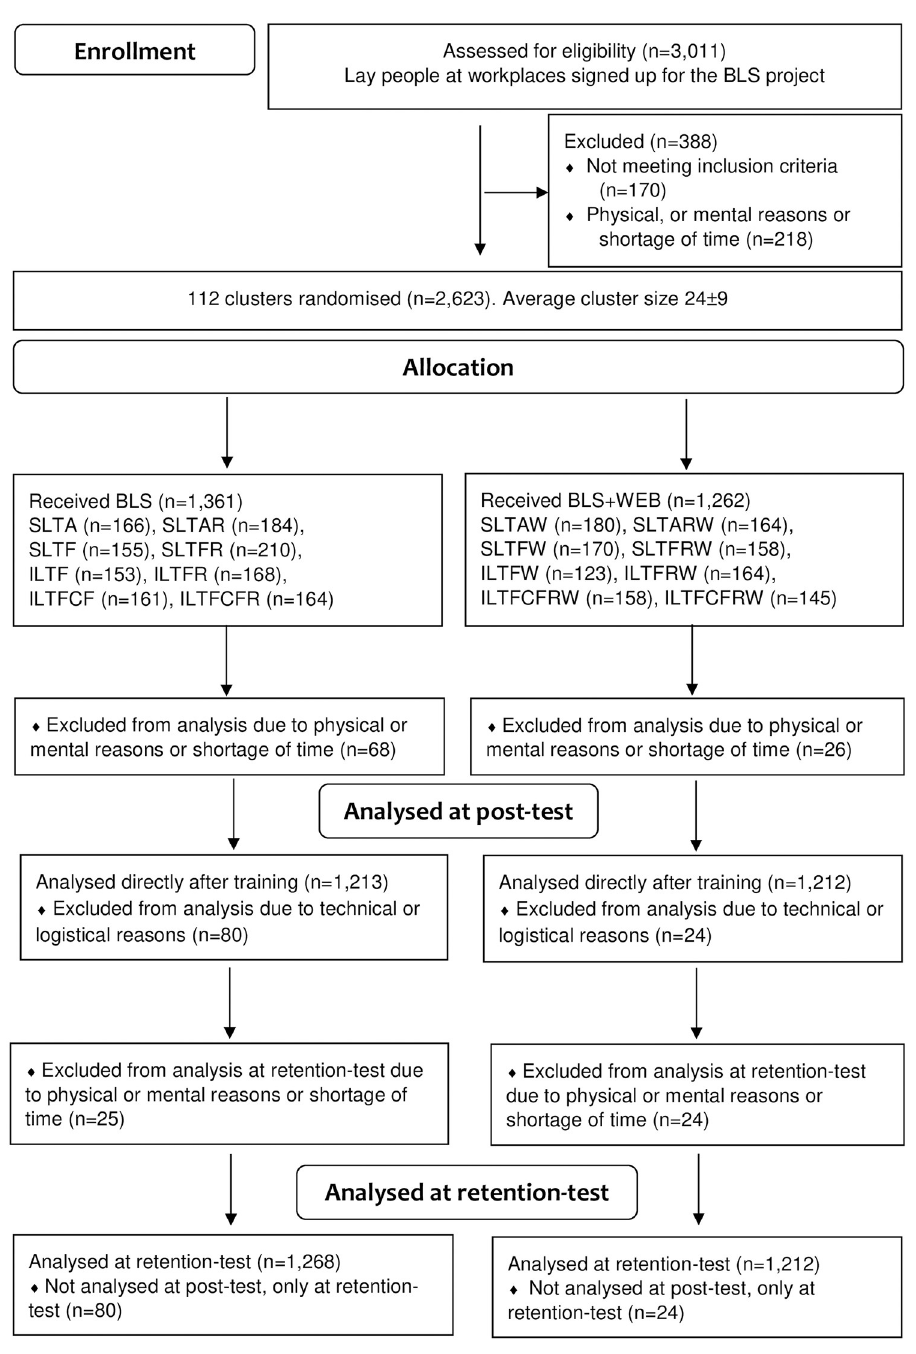
Fig 2. Flow-chart. Flow chart according to CONSORT (www.consort-statement.org), to compare the effectiveness of basic life support (BLS) education with preparatory web-based education in cardiovascular disease (CVD) in addition to BLS training (BLS+WEB). The participants were randomised, educated in BLS and assessed for their total score in practical skills of BLS. The post-test was performed directly after training and the retention test was performed six months after training. The main intervention was BLS education compared with BLS+WEB education. Additional training comprised self-learning training (SLT), instructor-led training (ILT), instructions from a mobile application (A), instructions from a video film (F), three reflective questions (R) and a device for feedback on compression depth (CF).